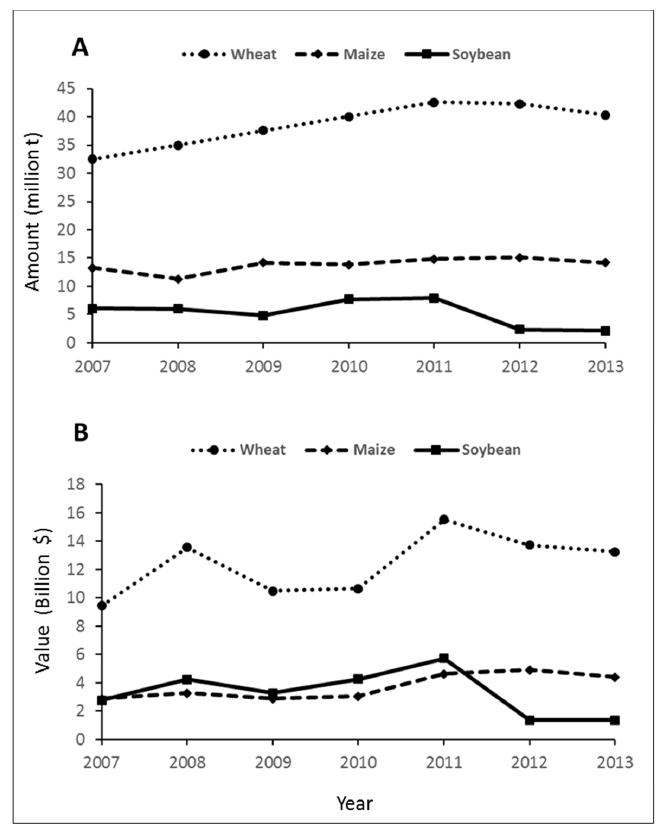
Figure 1. The top three crops imported by Africa from 2007 to 2013. ( A ) amount of import and ( B ) total value of three imported